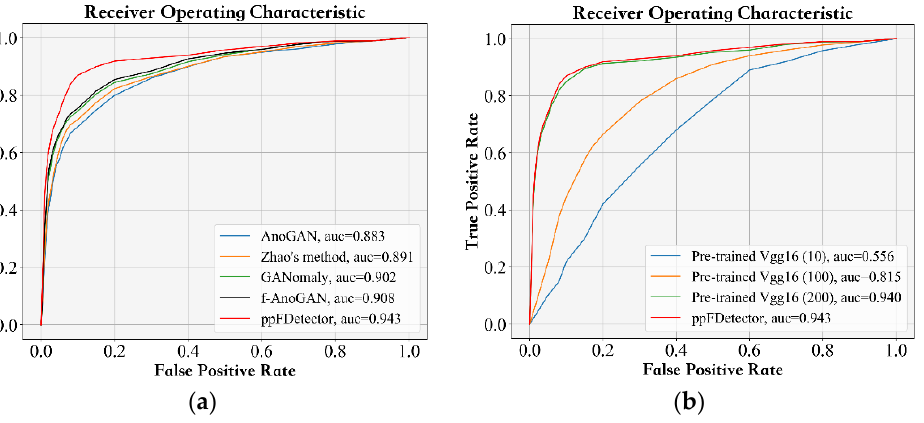
Figure 15. ROC curve comparison chart. ( a ) semi-supervised and unsupervised methods; ( b ) fully supervised methods.